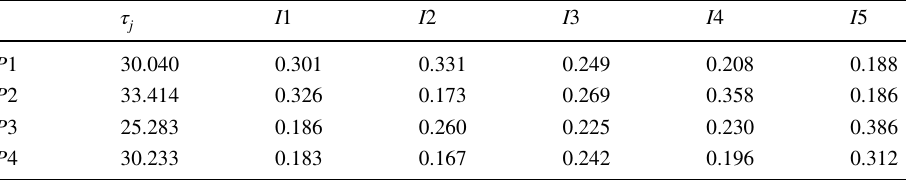
parameters for case V